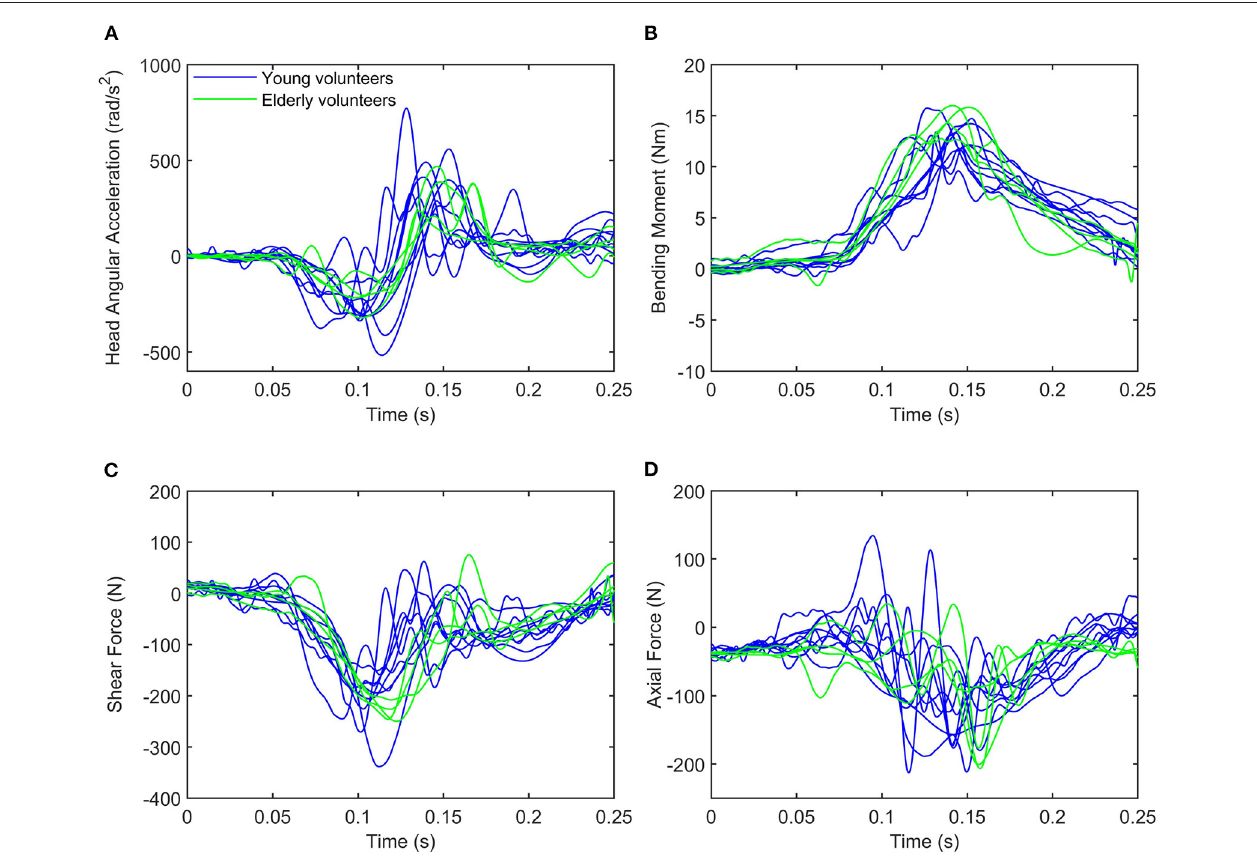
FIGURE 5 | Time history of (A) head angular acceleration, (B) bending moment, (C) shear force, and (D) axial force. The blue lines represent upper neck loading and head angular acceleration for young volunteers, while the green lines are used for elderly